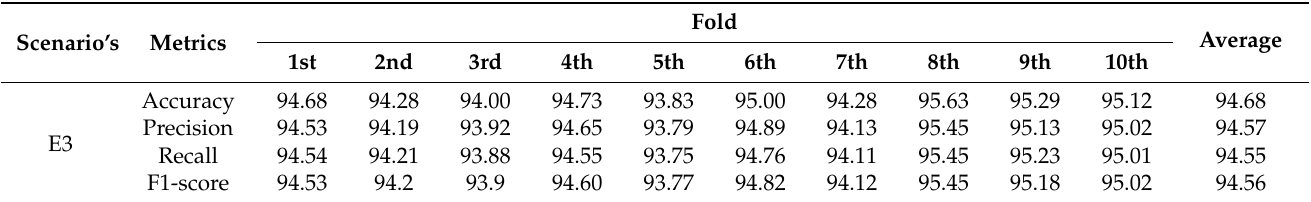
Table 6. The results of the STC-NLSTMNet model’s performance on the Multi-environment dataset on NLOS.